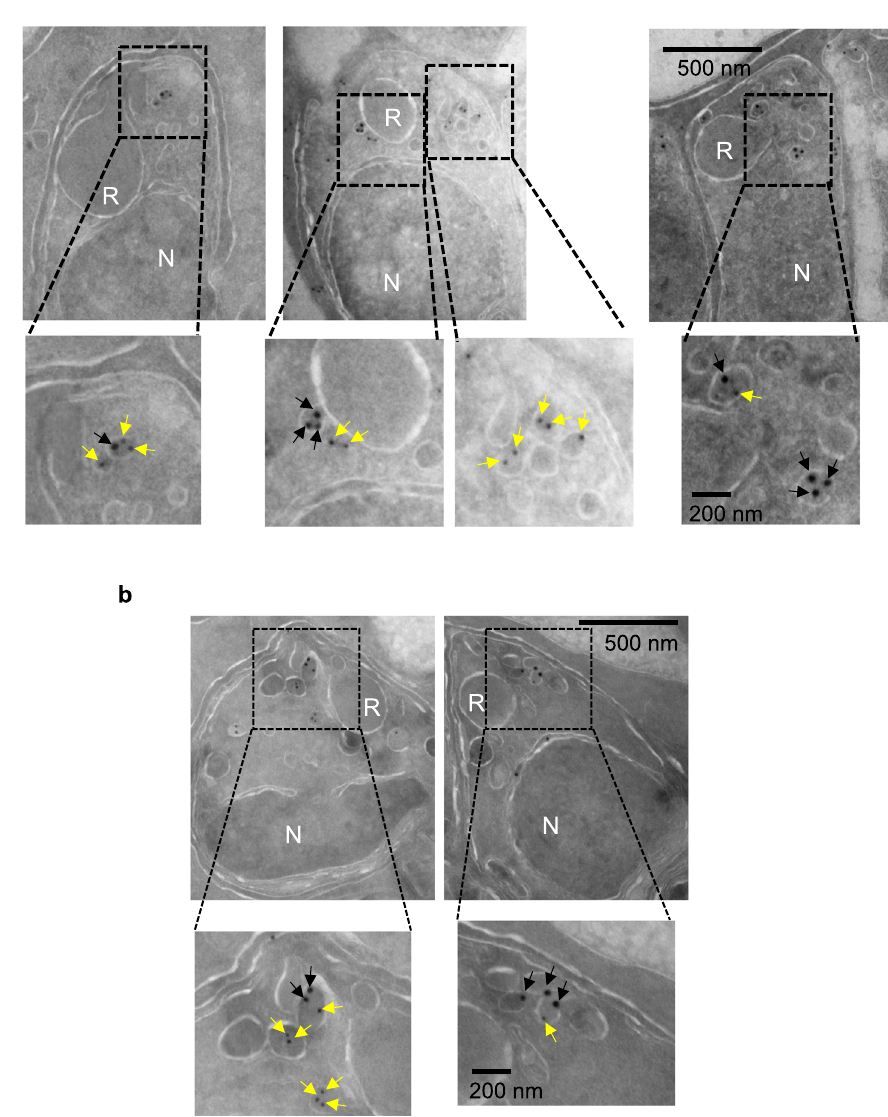
Fig.9|Asubsetoftheapicallylocatedvesiclesinschizontsshowcolocalization between AMA1 and PM X or SUB1 by immunoEM. Synchronized, C1-treated, 48 – 50h schizonts expressing either PM X-3xHA ( a ) or SUB1-3xHA ( b ) were pro- cessed as described in the methods. Thin section samples were labeled for the indicated markers and visualized by immunoelectron microscopy. Black arrows: